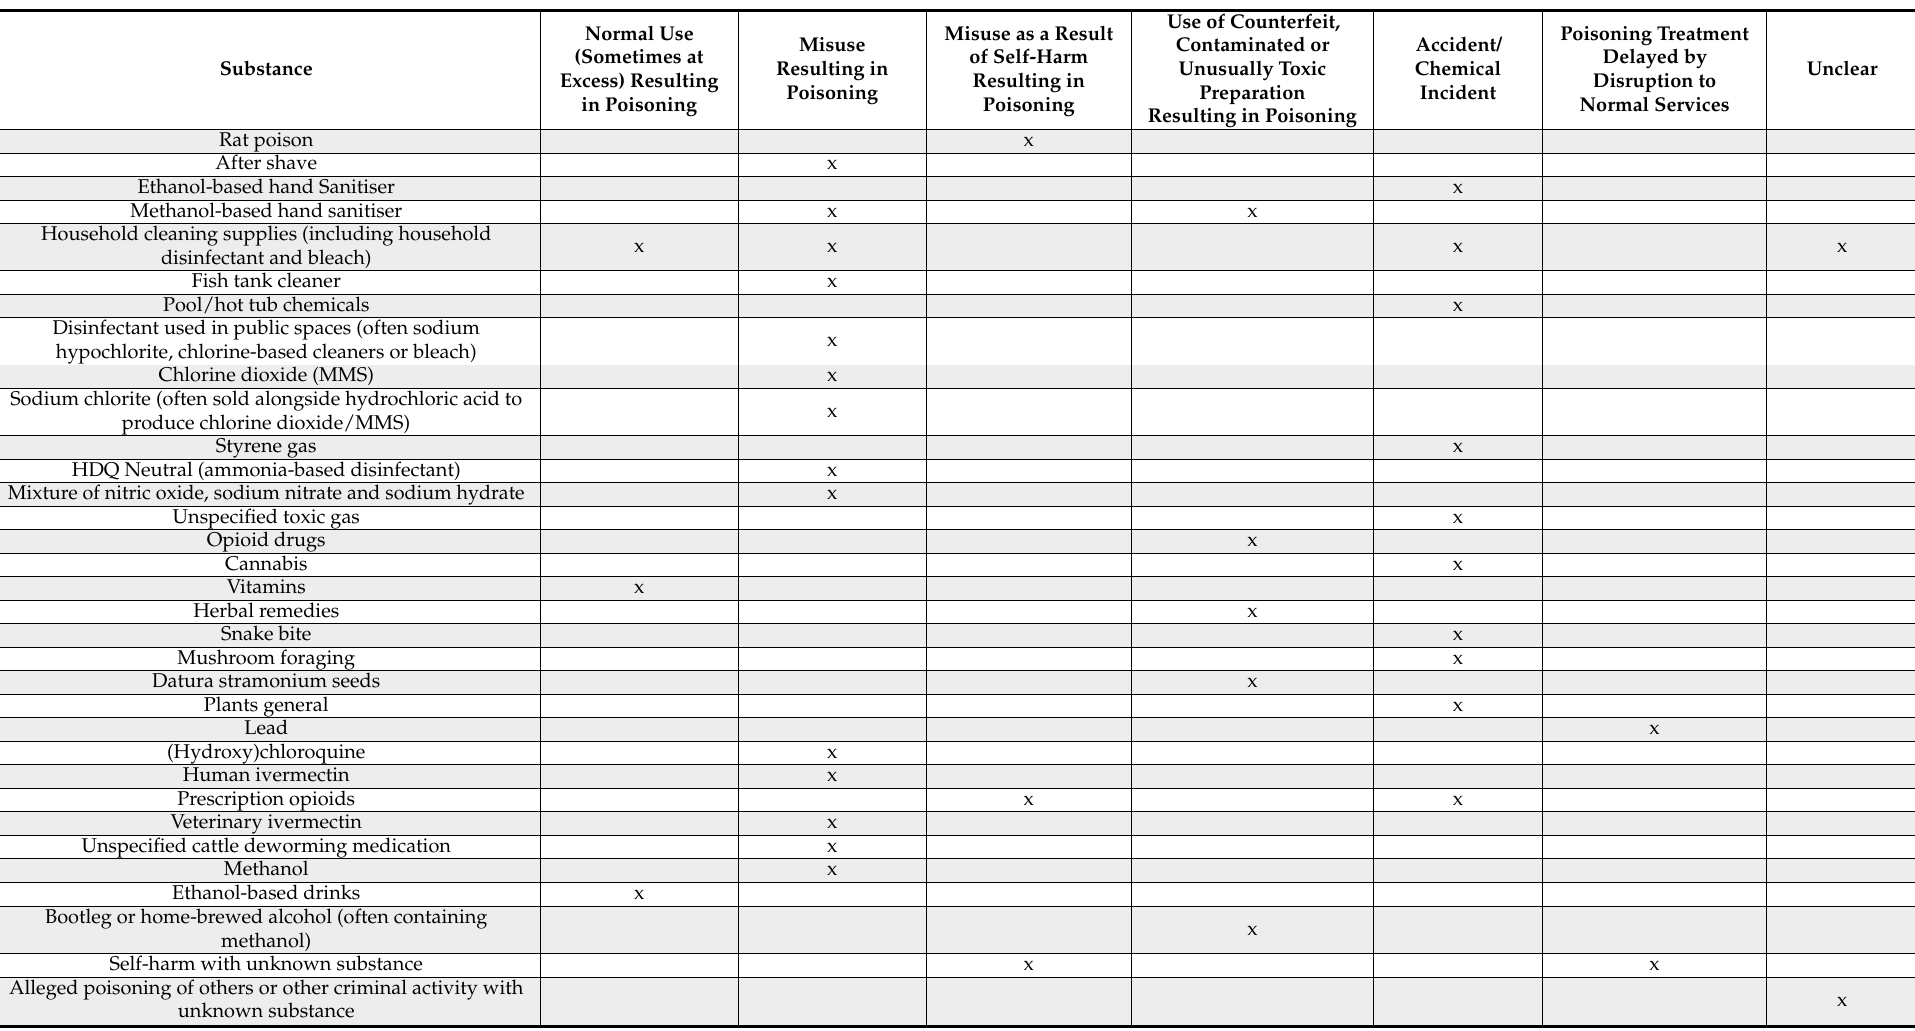
Table 3. Mode of exposure or